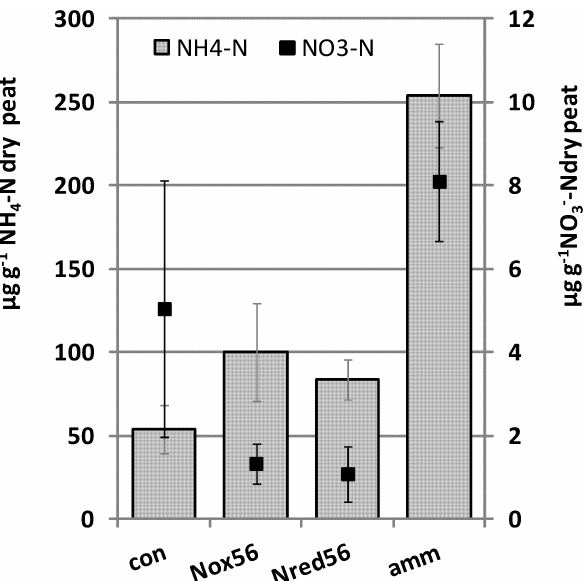
Fig. 4. KCl extractable NH 4 -N (grey bars) and NO 3 -N (small black squares) ( + / − sterr) in the surface 0–10cm peat from the control (no added N) and N treated (oxidised (Nox), reduced (Nred) and ammonia (amm)) plots ( ∼ 56kgNha − 1 yr − 1 ) at Whim bog in 2009 (November).